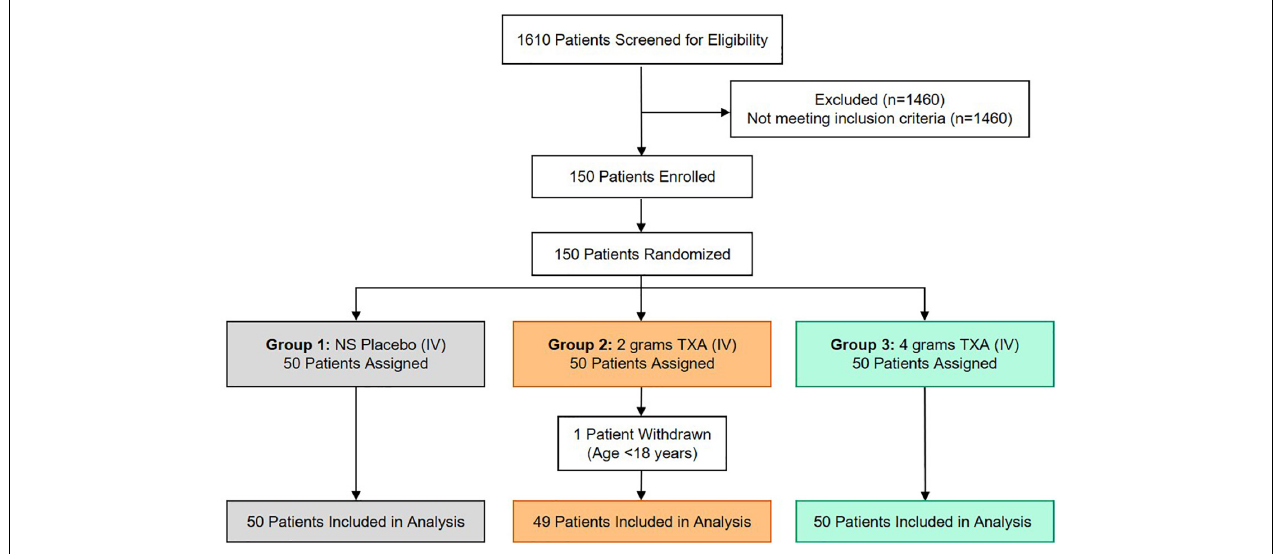
FIGURE 1 | TAMPITI Patient Screening, Enrollment, Randomization, and Analysis Diagram. This Consolidated Standards of Reporting Trials (CONSORT) diagram displays the number of patients screened for eligibility, excluded based on not meeting study inclusion criteria, patients enrolled and randomized, and the patients analyzed per study